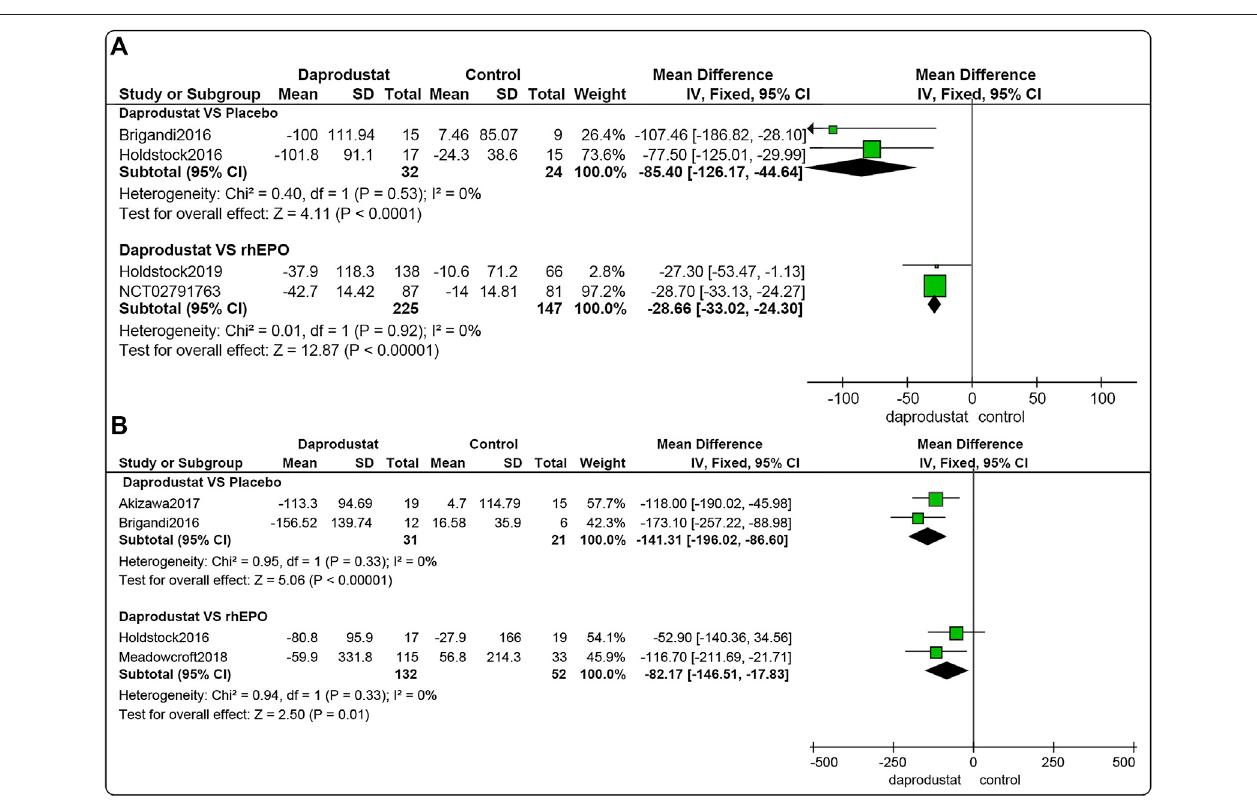
FIGURE 4 | The meta-analysis results of daprodustat for △ ferritin. (A) The pooled results for NDD patients; B : The pooled results for DD patients.